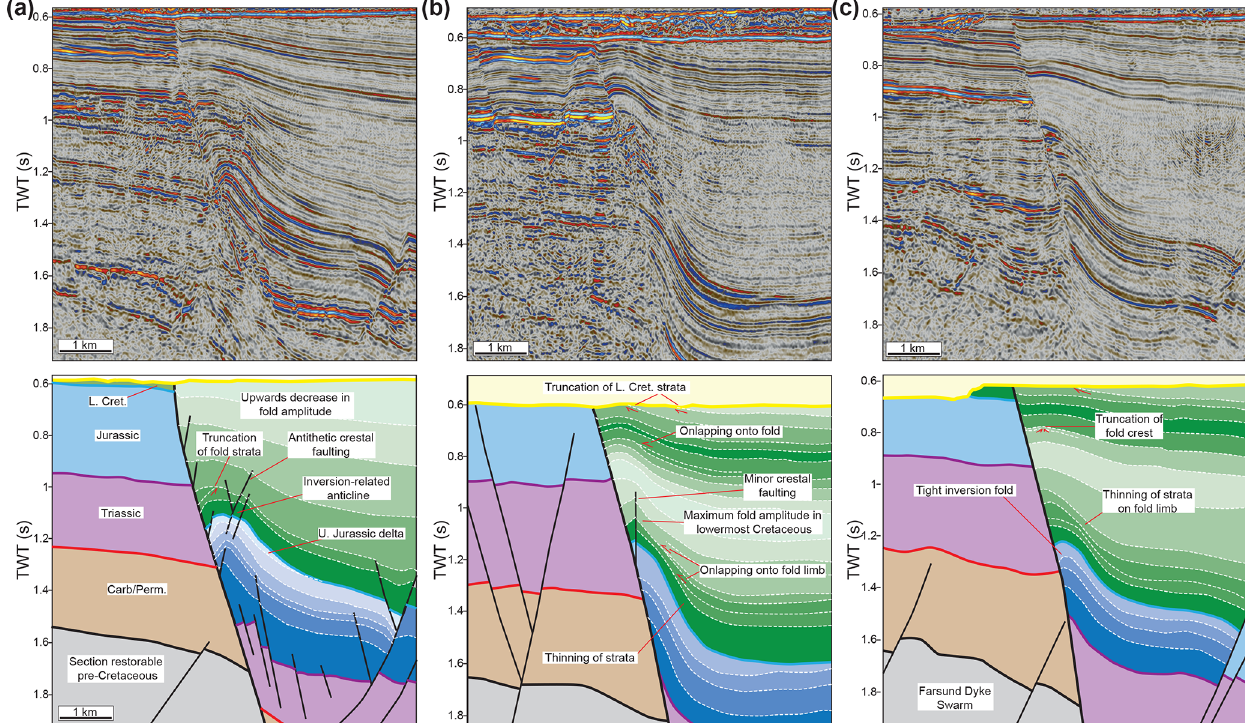
Figure 9. Uninterpreted and interpreted seismic sections highlighting the along-strike variability in fold geometry within Domain C. See Fig. 5a for locations. (a) Fold geometry in the west of Domain C showing a hangingwall anticline which decreases in amplitude upwards. (b) Section from the centre of Domain C; note how lowermost Lower Cretaceous strata onlap onto the limb of the fold at deeper levels. (c) Section from the east of Domain C; note how Lower Cretaceous strata thin onto the limb of the fold at deeper